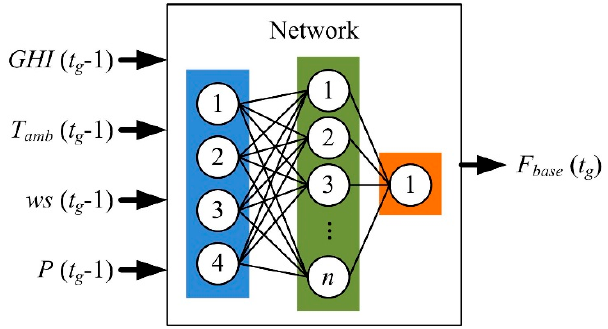
Figure 5. The structure of base neural network (NN) predictor.